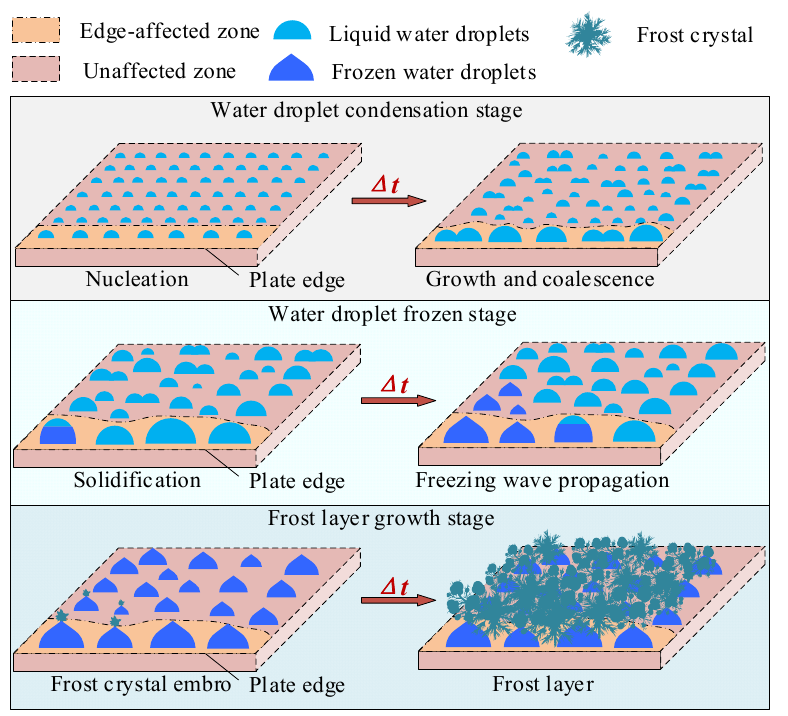
Figure 2. Schematics of the temporal and spatial divisions of condensation frosting stages in the edge region of a cold plate.